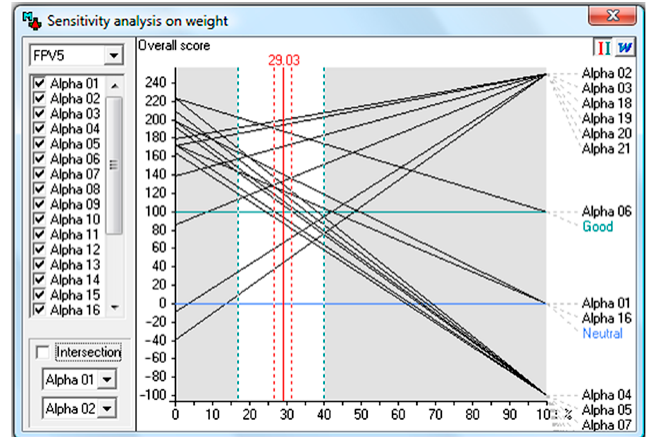
Fig. 6. Sensitive analysis on FPV